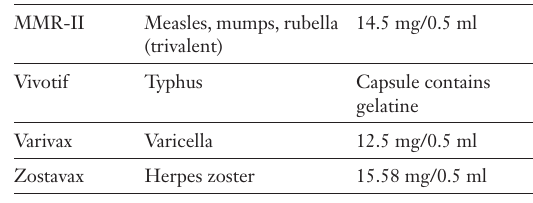
Gelatine containing vaccines in Switzer- land 2008.